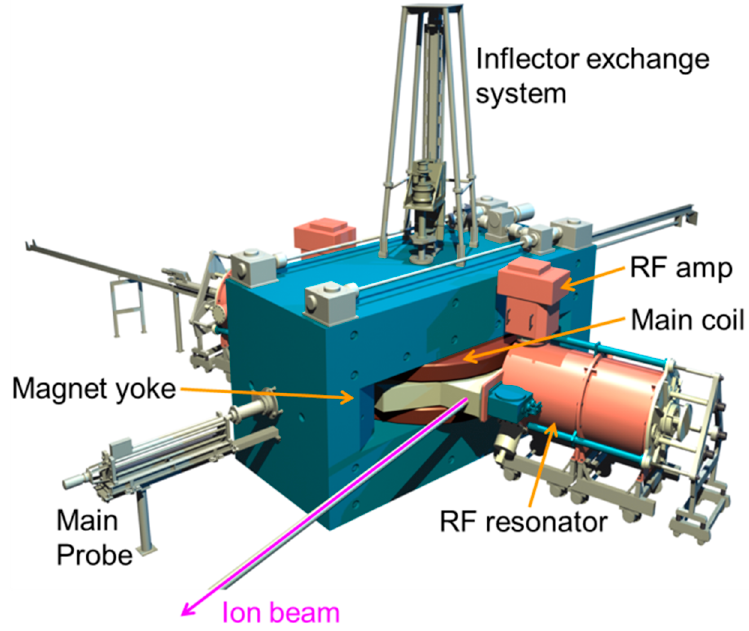
Figure 7. An illustration of the TIARA azimuthally-varying field (AVF) cyclotron. Size and weight of the magnet yoke are 5190 × 2310 × 2600 mm and 220 tons, respectively. Table 1. Specification of the TIARA cyclotron.